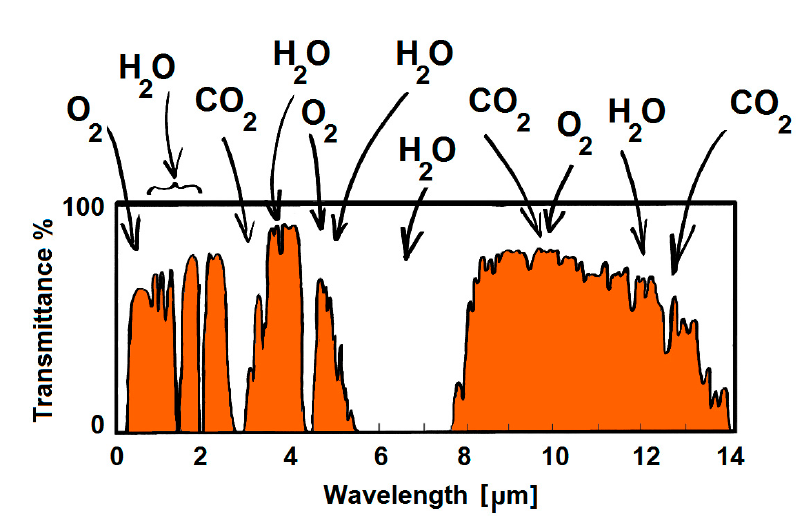
Figure 6. Atmospheric transmission spectrum up to 14 µ m showing the wavelength regions where particular molecules absorb the electromagnetic wave.